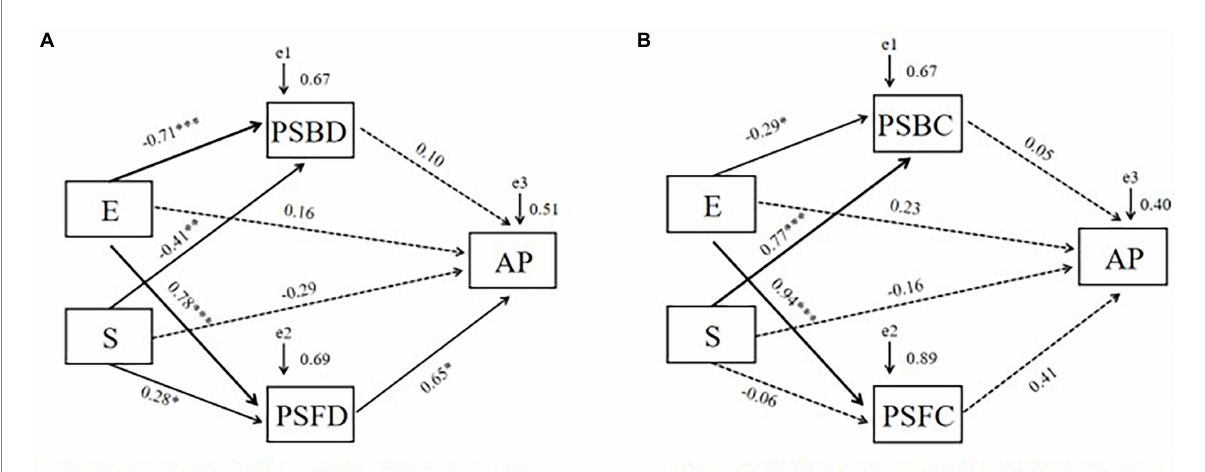
FIGURE 5 The structural equation model (SEM) showing the hypothesized causal relationships between explanatory factors [ (A) PSF and PSB diversity; (B) , PSF and PSB community composition] and available phosphorus concentration in rhizosphere soil of tall fescue under saline-alkali stress. The width of arrows indicates the strength of the standardized path coefficient (***, p < 0.001; **, p < 0.01; *, p < 0.05). The e-values represent residuals. E, endophyte infection status; S, saline-alkali stress; PSFD, phosphorus solubilizing fungal diversity; PSBD, phosphorus solubilizing bacterial diversity; PSFC, phosphorus solubilizing fungal community composition; PSBC, phosphorus solubilizing bacterial community